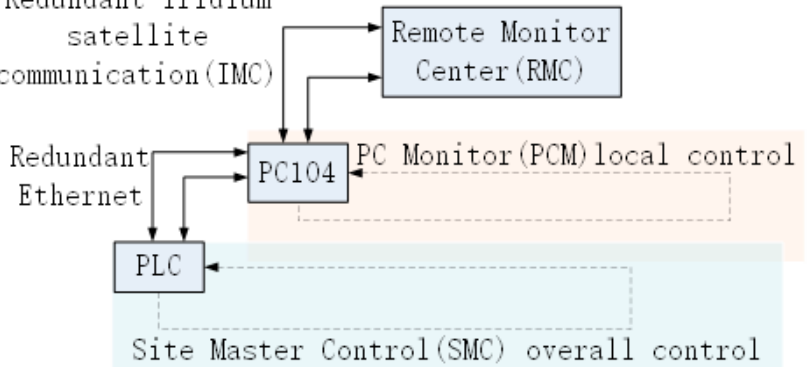
Figure 9. Data generation (the dotted line) and flow (the full line).